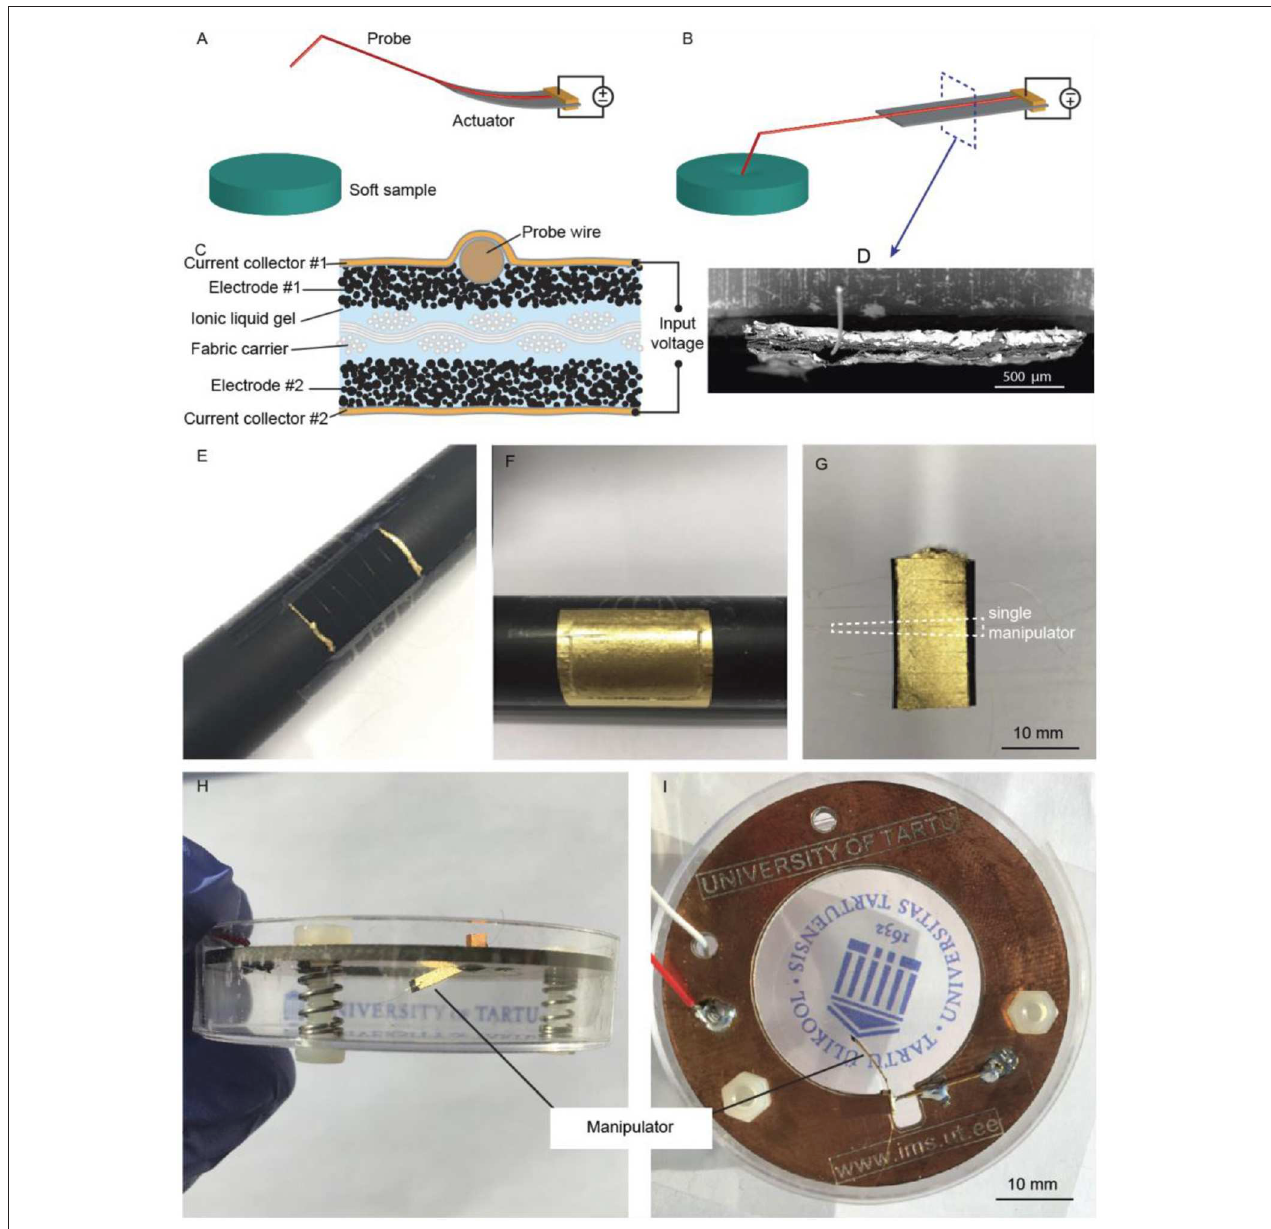
FIGURE 4 | The electroactive probe manipulator concept, shown in (A) not contacted and (B) contacted mode. (C) Schematic and (D) SEM image of the cross-section of the ICL manipulator, showing the location of the wire probe. Snapshots recalled from the fabrication: (E) metal wires were placed on the electrode surface; (F) metal wires were fixed in place under the gold current collector; and, finally, (G) the manipulators were formed by cutting. Photographs of the (H) side and (I) top view the final device.